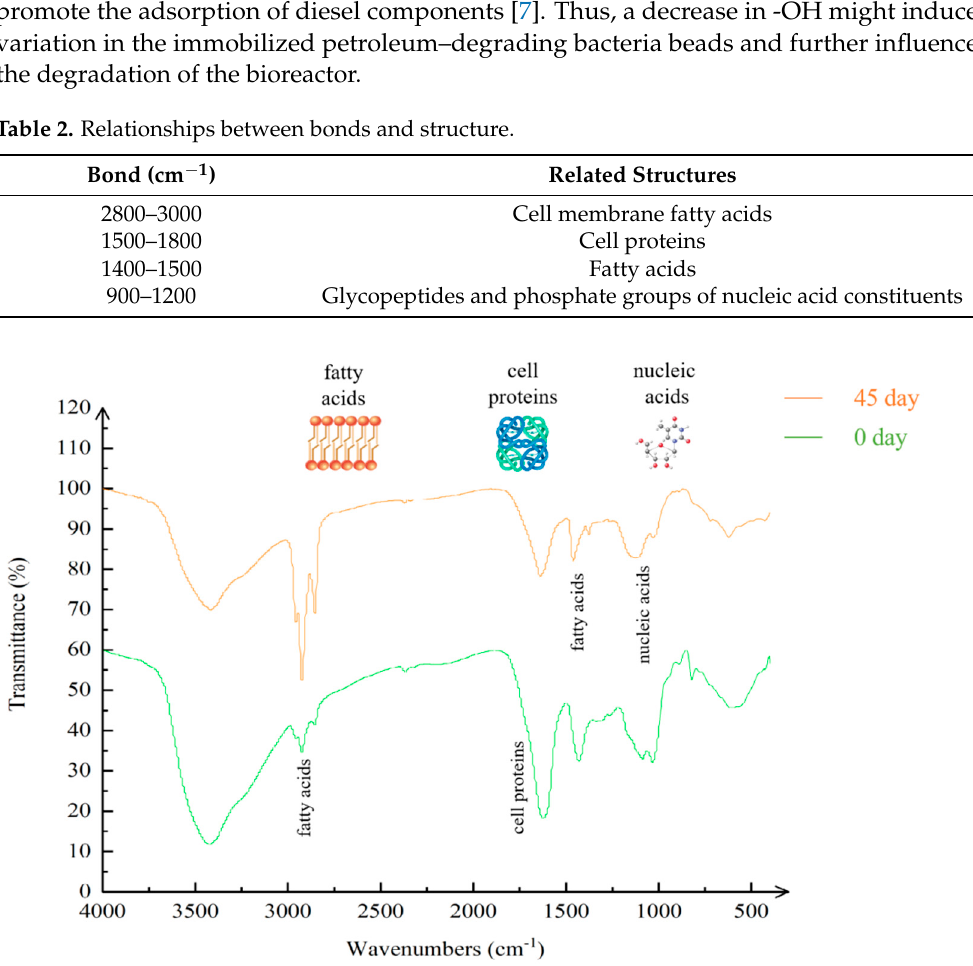
Figure 3. Fourier transform infrared spectroscopy (FTIR) analysis of the initial immobilized petroleum–degrading bacteria beads and the immobilized petroleum–degrading bacteria beads in the bioreactor after 45 days, represented by the green and orange lines,